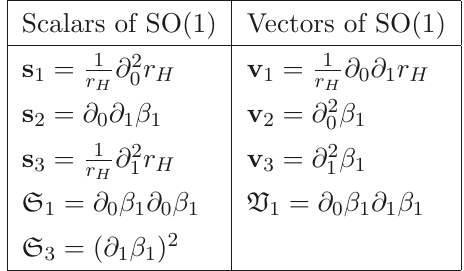
Table 2 . The list of all the second order viscous terms for D1-brane. The vector viscous terms are reduced to scalars in this case but we still call them